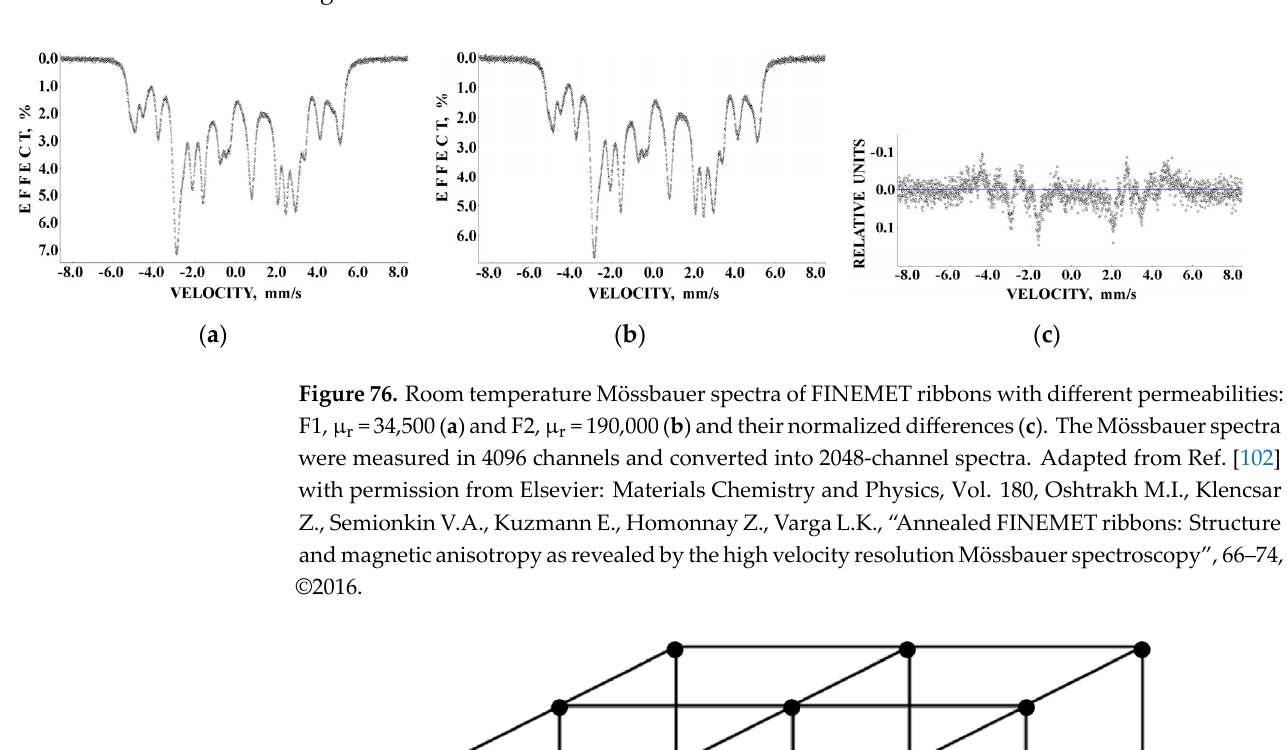
(620) ( b ) Figure 75. XRD patterns of FINEMET ribbons with different permeabilities: F1, μ r = 34,500 ( a ) and F2, μ r = 190,000 ( b ) with indicated Miller indices. Adapted from Ref. [102] with permission from Elsevier: Materials Chemistry and Physics, Vol. 180, Oshtrakh M.I., Klencsar Z., Semionkin V.A., Kuzmann E., Homonnay Z., Varga L.K., “Annealed FINEMET ribbons: structure and magnetic